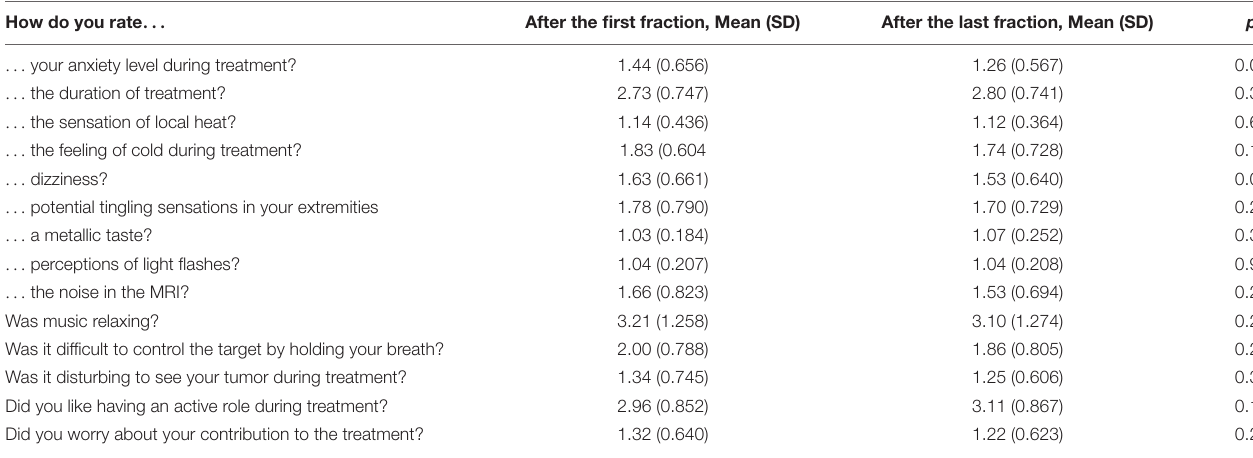
TABLE 3 | Result of the patient reported outcomes. How do you rate